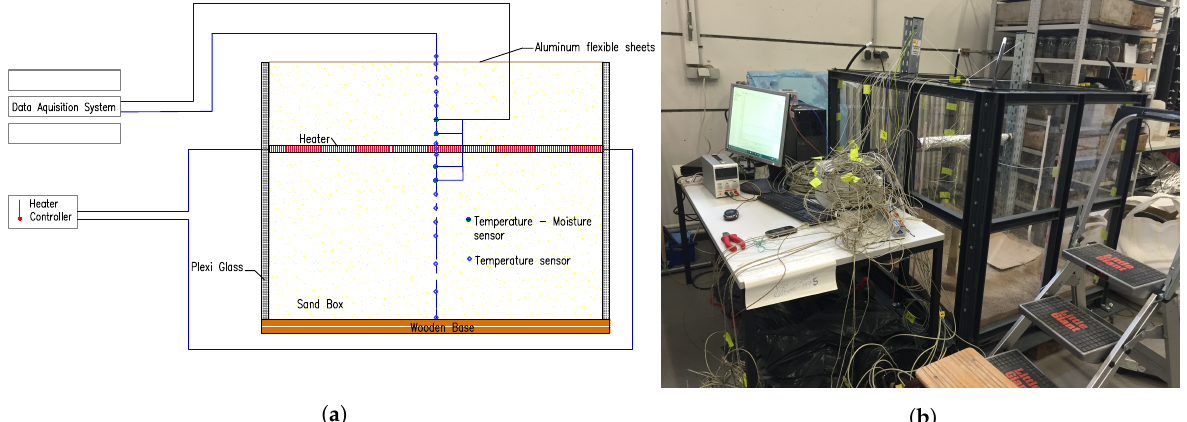
Figure 3. The experimental setup with ( a ) Schematic diagram of heating control unit and thermocouple arrangement with data acquisition unit; ( b ) large scale box setup showing heating and temperature control